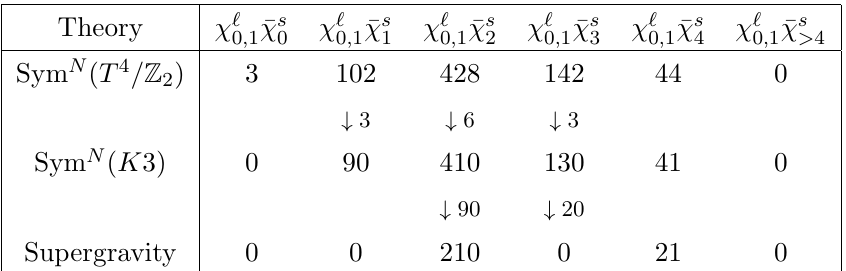
for Sym N ( T 4 = Z 2 ), Sym N ( K 3), and 0 ; 1 in (3.7) for (cid:22) j = 0 ; 1 ; 2 ; : : : N . A number n 0 ; 1 ; (cid:22) j represents 2 n short multiplets of type j